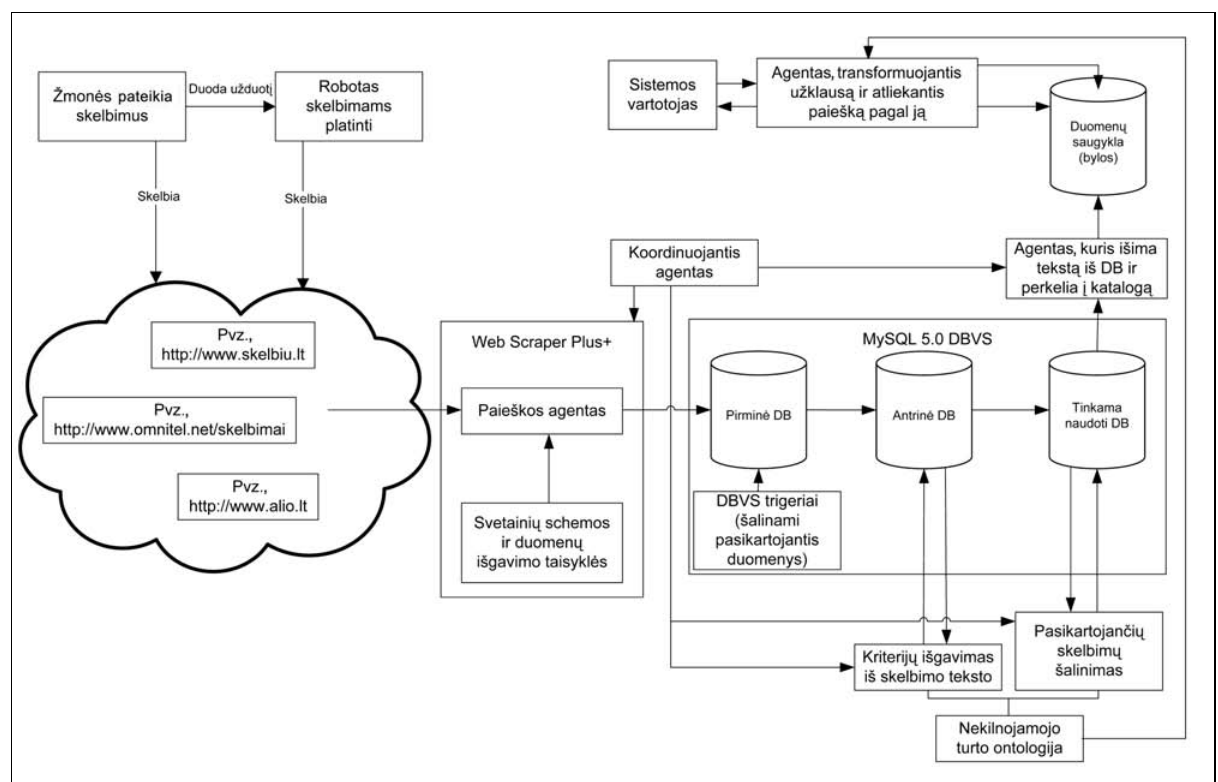
Fig 1. The architecture agent of realty which uses